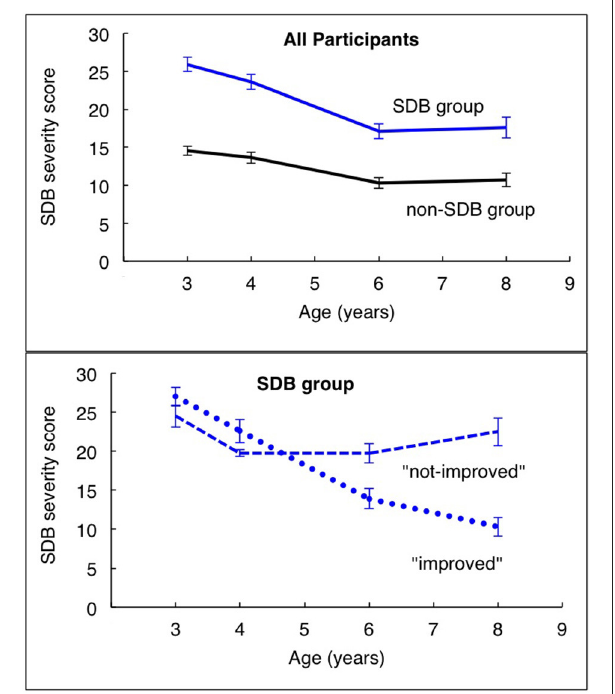
FIGURE 1 | Mean ± sem SDB severity scores for each group evaluated across the four ages of assessment. Top graph represents SDB and non-SDB groups categorized by SDB severity scores at study entry (age 3). Bottom graph represents the SDB group further stratified by those whose scores had improved, or not, over the 5 year course.